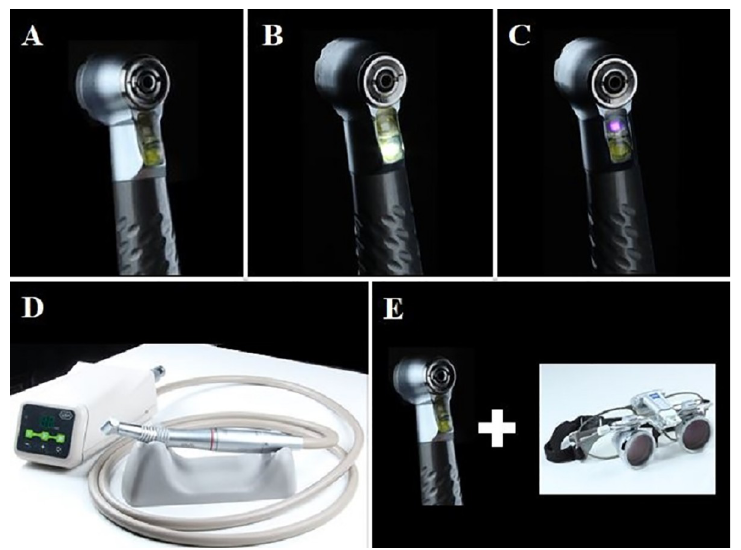
Fig 1. Auxiliary devices according to each group. (a) removal with high-speed handpiece without auxiliary device (WD), (b) removal with high-speed handpiece with a white (WL), (c) removal with high-speed handpiece with an UV light (UL) attached, (d) removal with electric motor and multiplier 1/5 handpiece (EM). (e) removal with conventional high-speed handpiece using magnifying loupe